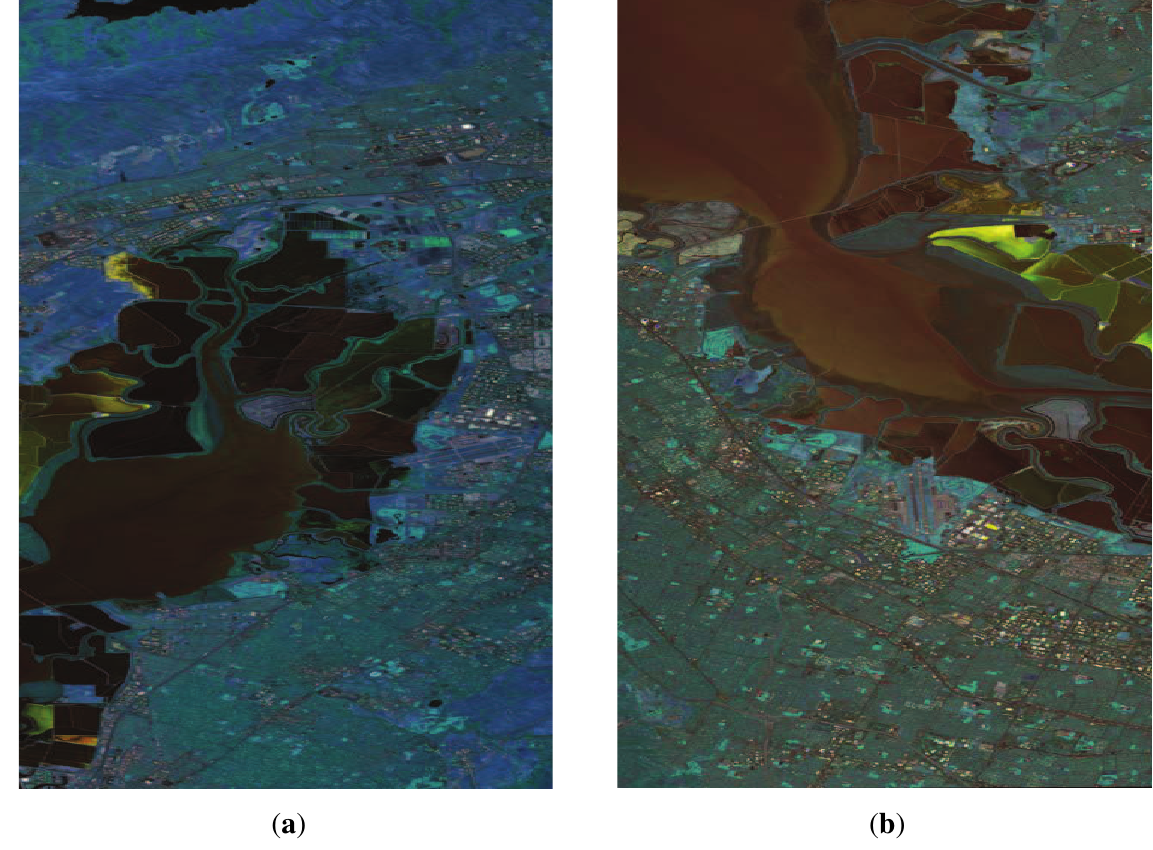
Figure 11. Visualization results with our proposed PDADVS on the original images: ( a ) Moffett _ igm ; and ( b ) Moffett 02